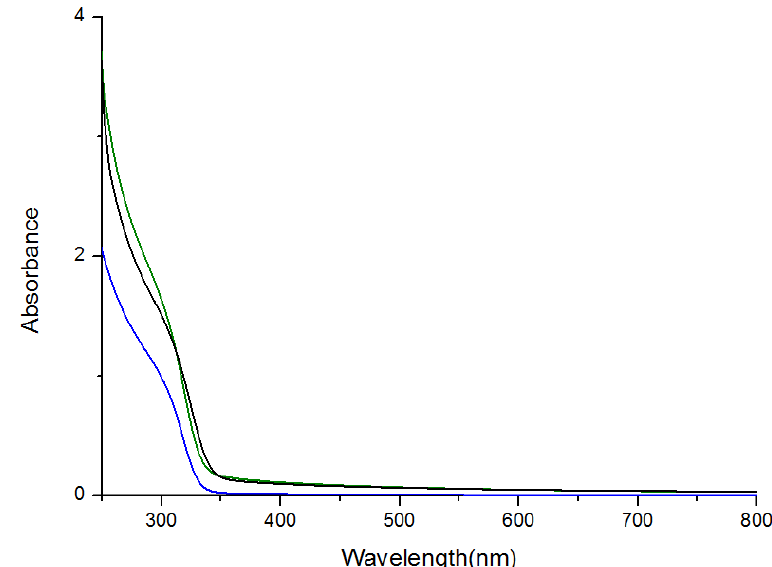
Figure 2. Ultra violet (UV)-visible absorption spectra of the ZnS:Mn-MAA NCs prepared at pH 2 (blue); pH 7 (green); and pH 12